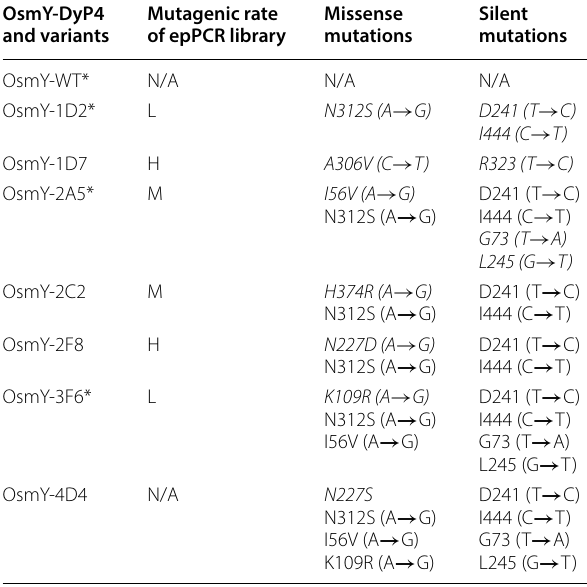
Clones labelled with an asterisk * were used as parental template for the subsequent round of mutagenesis; mutations in italics represent nucleotide substitutions added to a parental template The best variant, OsmY-4D4, carries 4 amino acid substitutions (I56V, K109R, N227S and N312S; Fig. 3 and Additional file 1: Figure S6) along with 4 other silent mutations (Table 2). The crystal structures of F194Y (PDB 6FSK) and F194W (PDB 6FSL) variants of DyP4 were recently released. Residues 56 and 109 are located within α-helices, while the other two residues